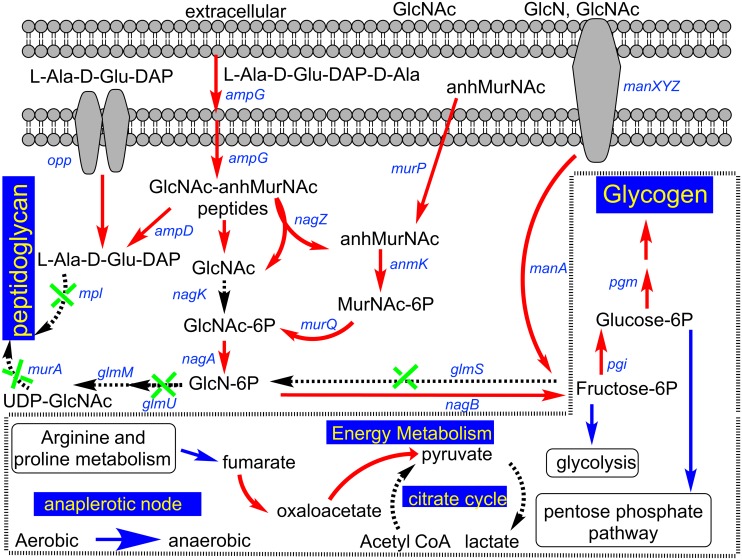
Pathway analysis.A schematic presentation of metabolic pathways affected in A. actinomycetemcomitans (IDH781 and EA1002) strains. Red arrows indicate up-regulated genes in EA1002 while dashed black arrows indicate no change in expression. Green crosses on dashed black arrows refer to down-regulated genes whereas the blue arrows indicate intermediates feeding into a pathway.